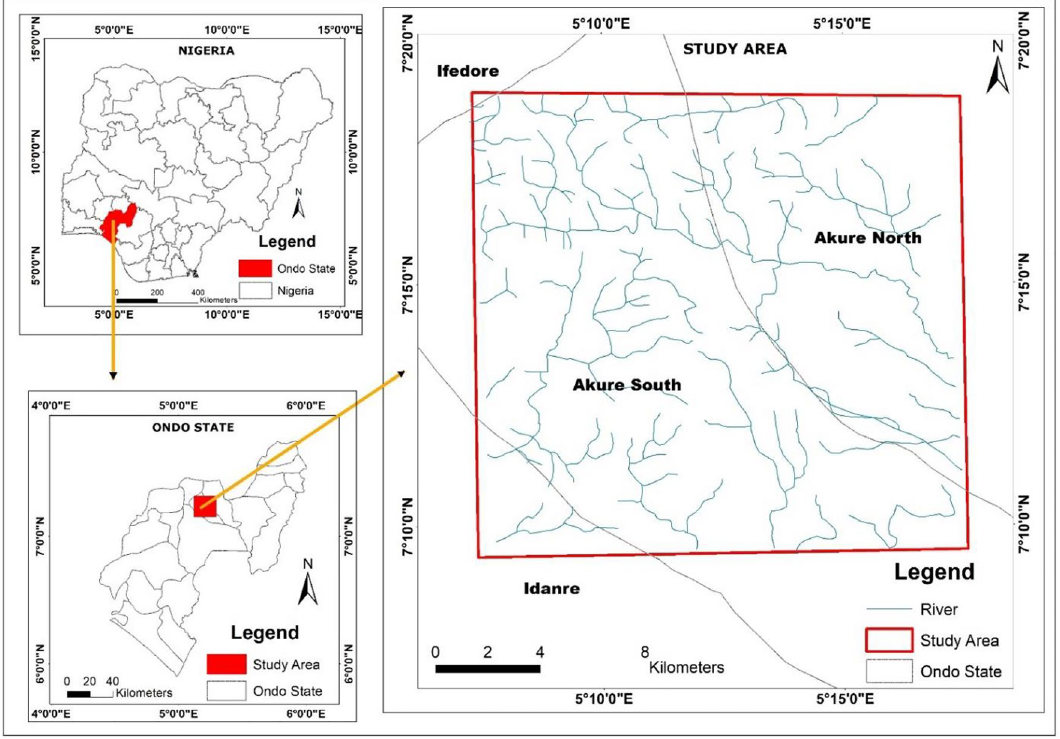
Fig. 1 The study area in Akure, Ondo State,